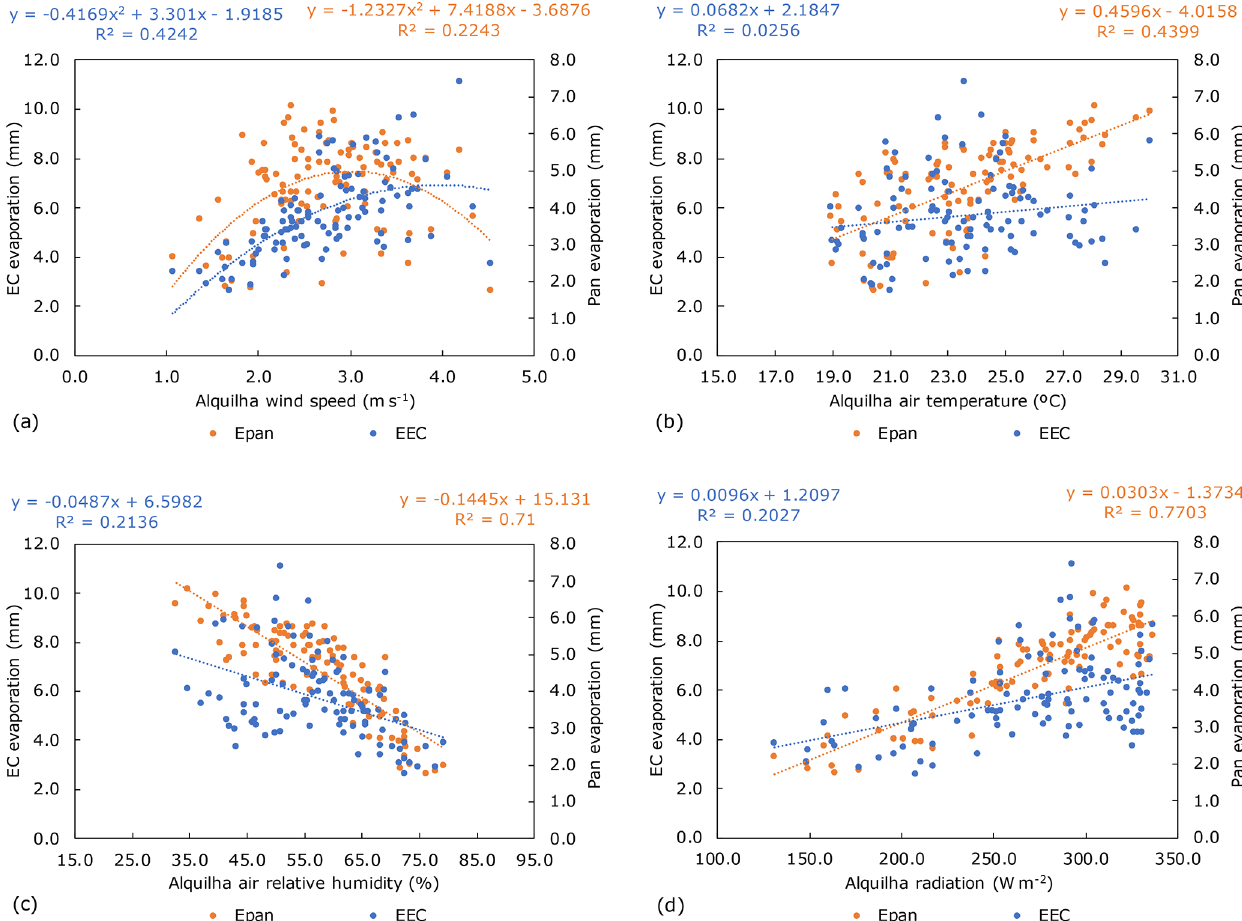
Figure 9. Sensitivity analysis of the daily EC evaporation ( E EC ) and the daily pan evaporation ( E pan ) from June to September 2014, with